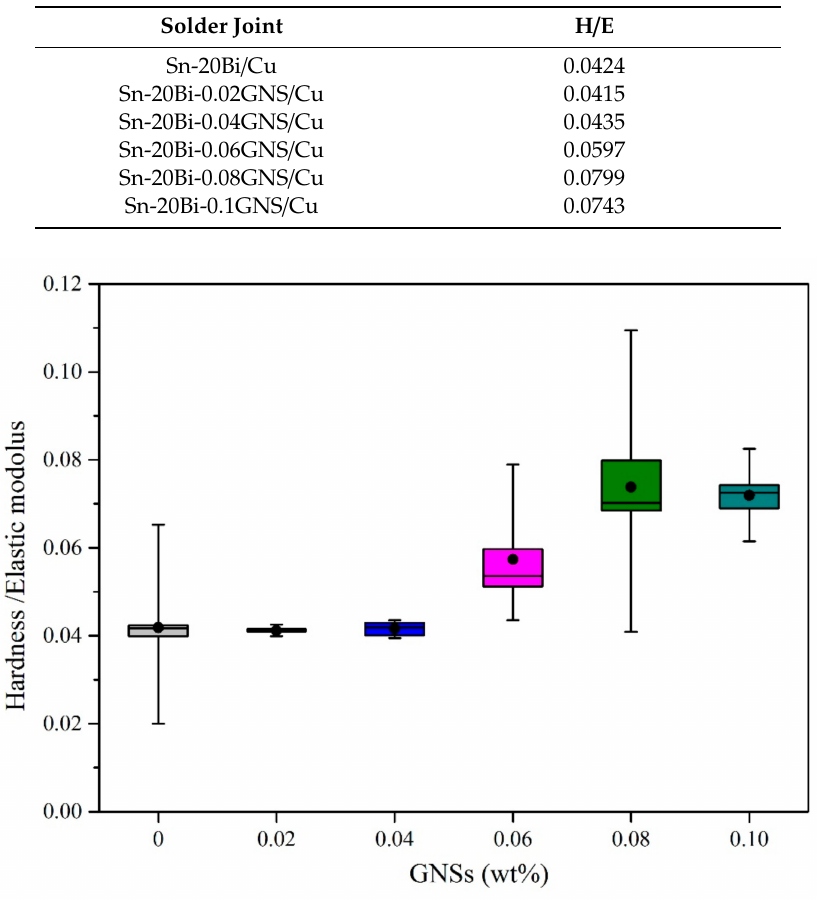
Table 5. The ratio of hardness / elastic modulus of IMCs at the Sn-20Bi-xGNS / Cu solder joint.